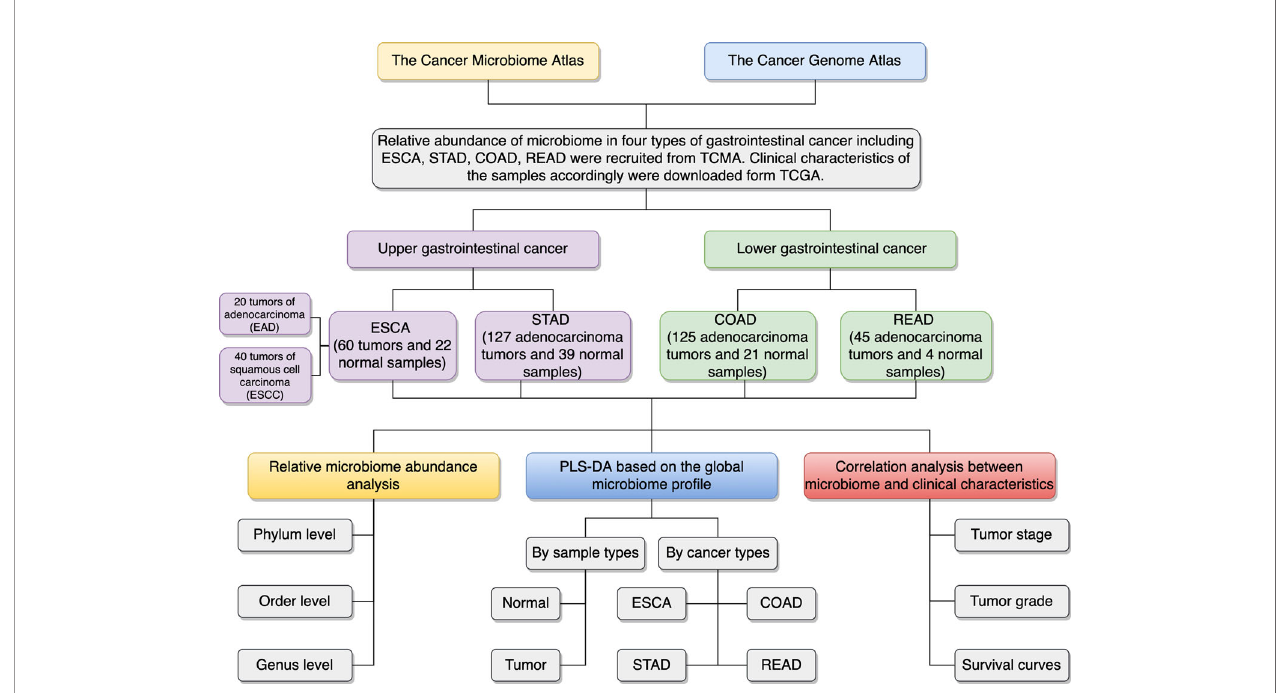
FIGURE 1 | Schematic overview of the study design and work fl ow. TCMA, The Cancer Microbiome Atlas; TCGA, The Cancer Genome Atlas; ESCA, esophageal carcinoma; EAD, esophageal adenocarcinoma; ESCC, esophageal squamous cell carcinoma; STAD, stomach adenocarcinoma; COAD, colon adenocarcinoma; READ, rectum adenocarcinoma; PLS-DA, partial least squares discrimination